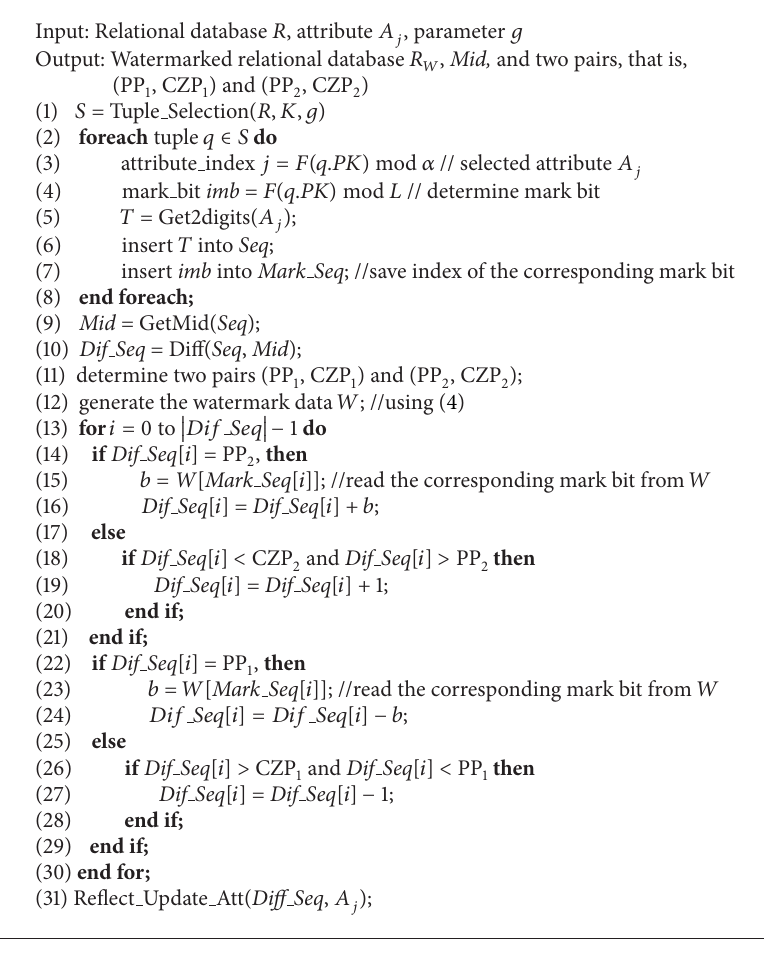
Algorithm 2: Watermark